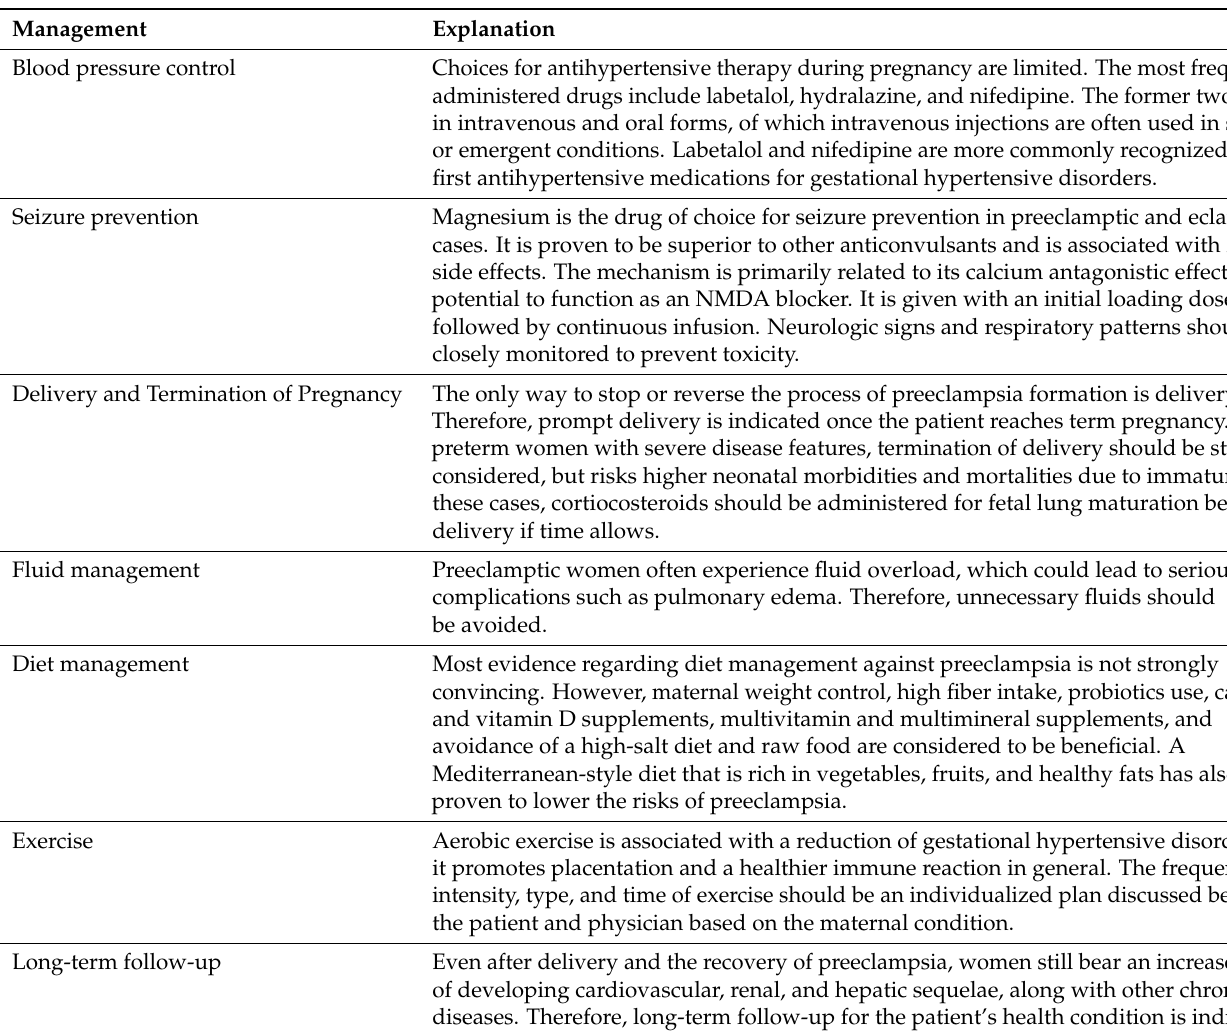
Table 7. A summary of current management practices of